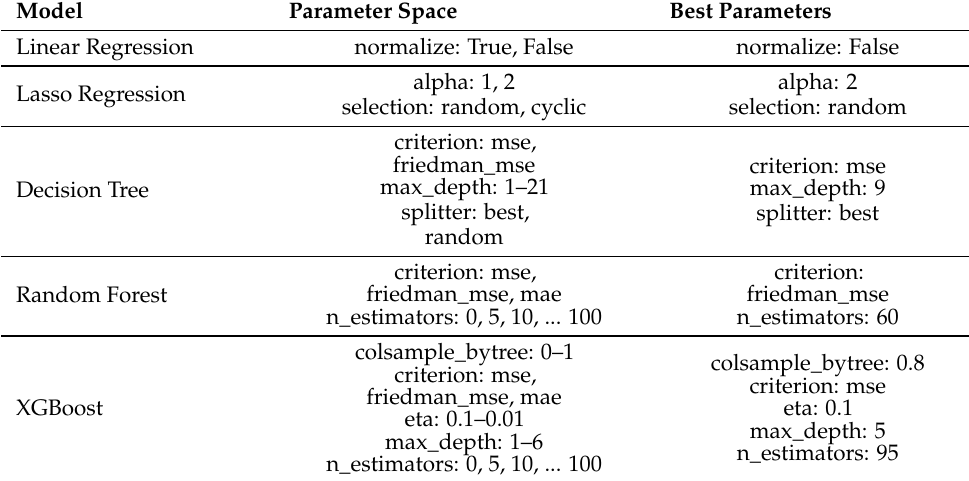
Table 6. Parameter Space and Best Parameters of Models.